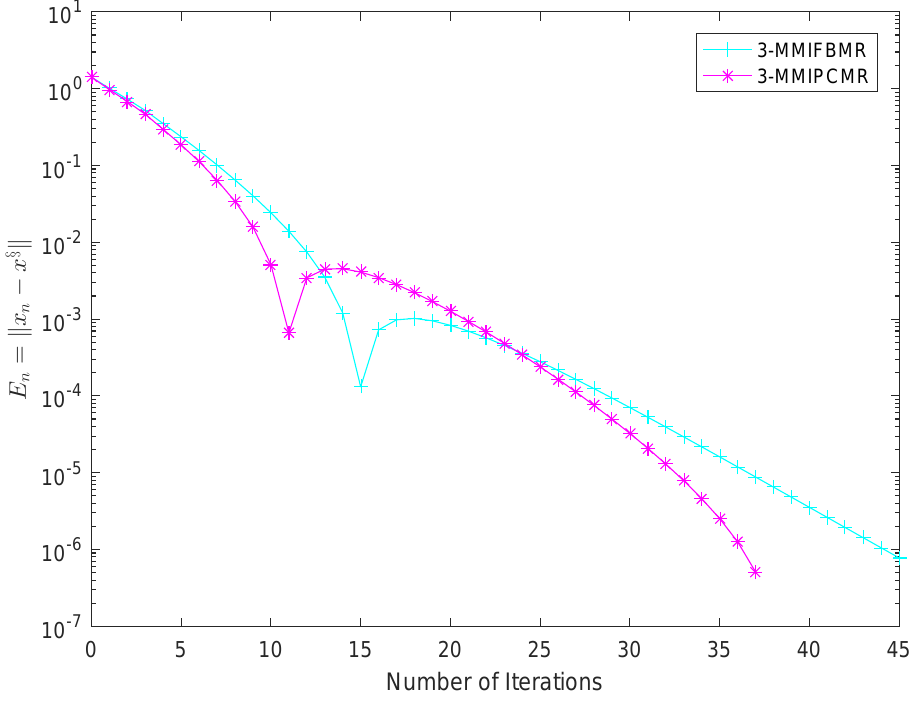
Figure 8. Comparison of 3-MMIFBMR and 3-MMIPCMR in Example